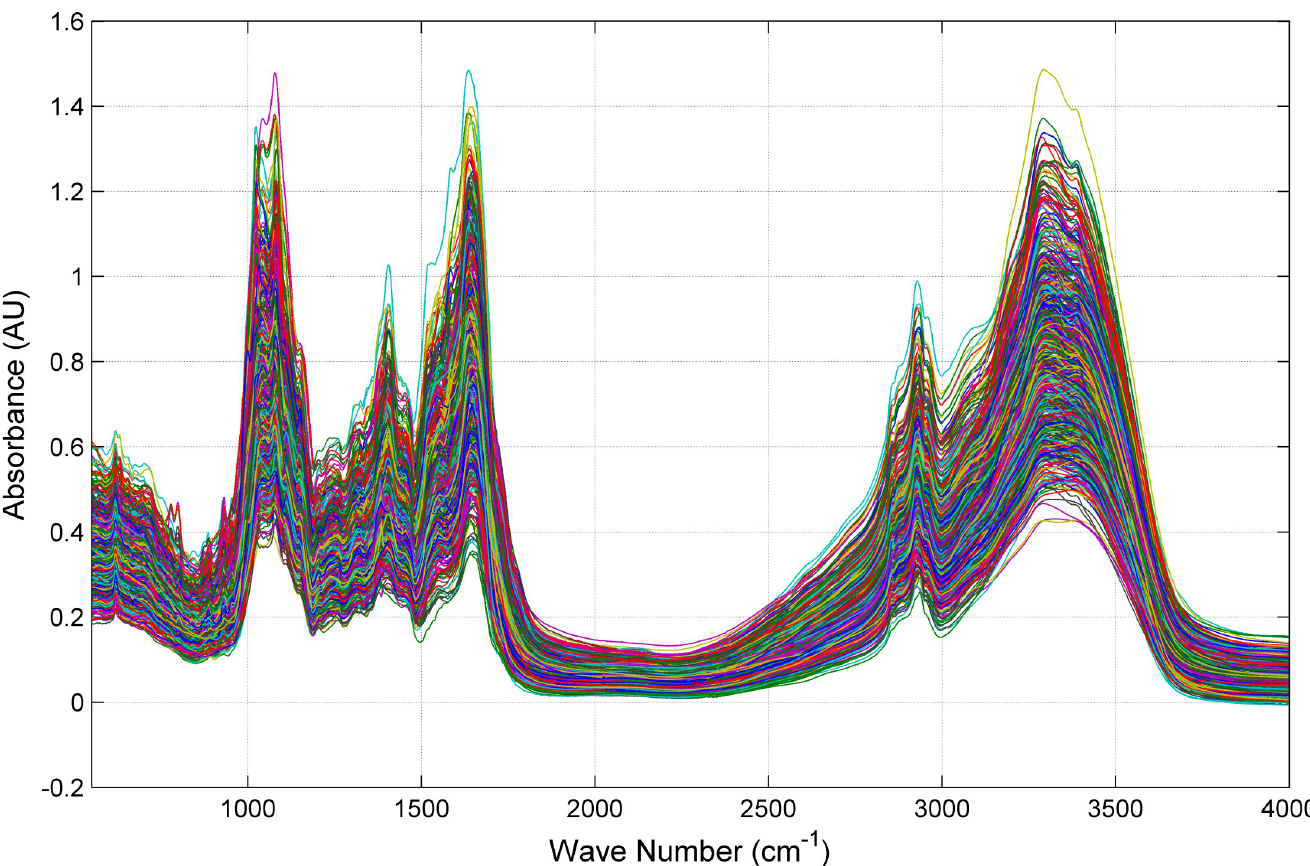
Fig 2. Mid-infrared spectral of 658 Cornus officinalis samples from 11 different places of origin. Figs are generated using Matlab (Version R2021b, https://www. mathworks.com/) [Software].